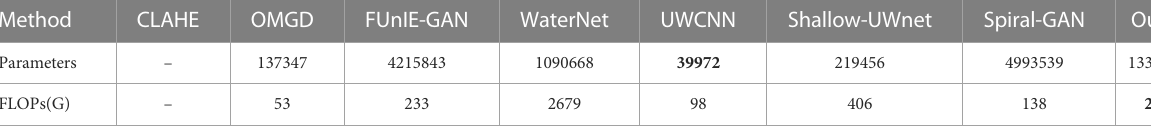
The bold indicates the best